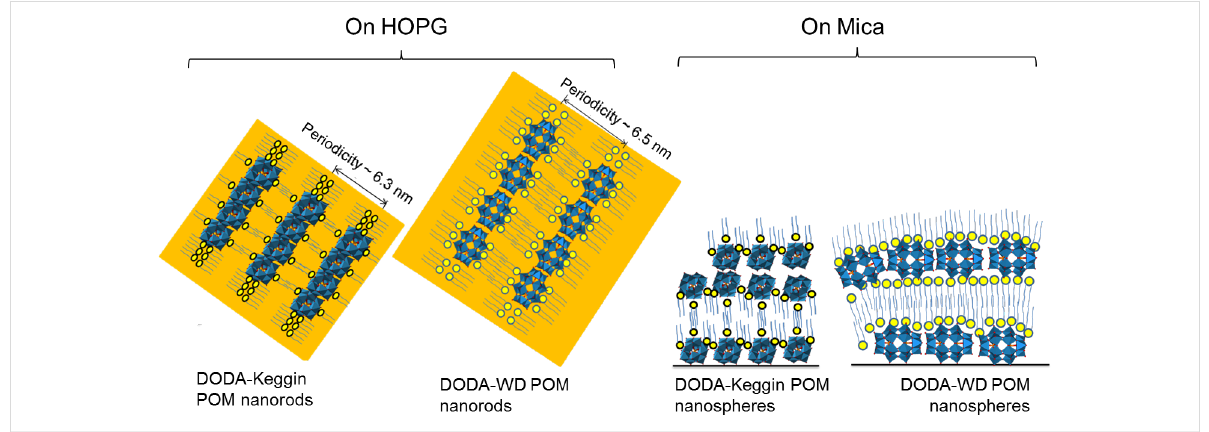
Figure 5: Supramolecular organization of DODA–POM hybrids on HOPG and mica surfaces.